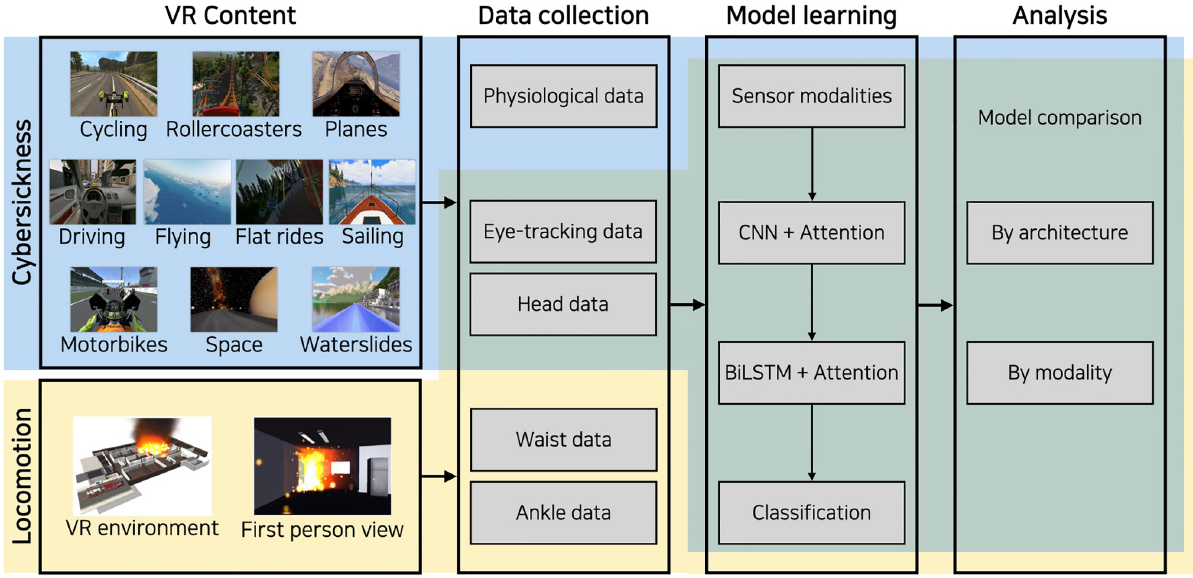
Fig 1. The study procedure. Each study has its own VR content, providing participants with the proper environment for cybersickness or locomotion. We collected eye-tracking, head, and physiological data from the cybersickness study and collected eye-tracking, head, waist, and ankle data from the locomotion study. We used the same model architecture and analysis methods for both